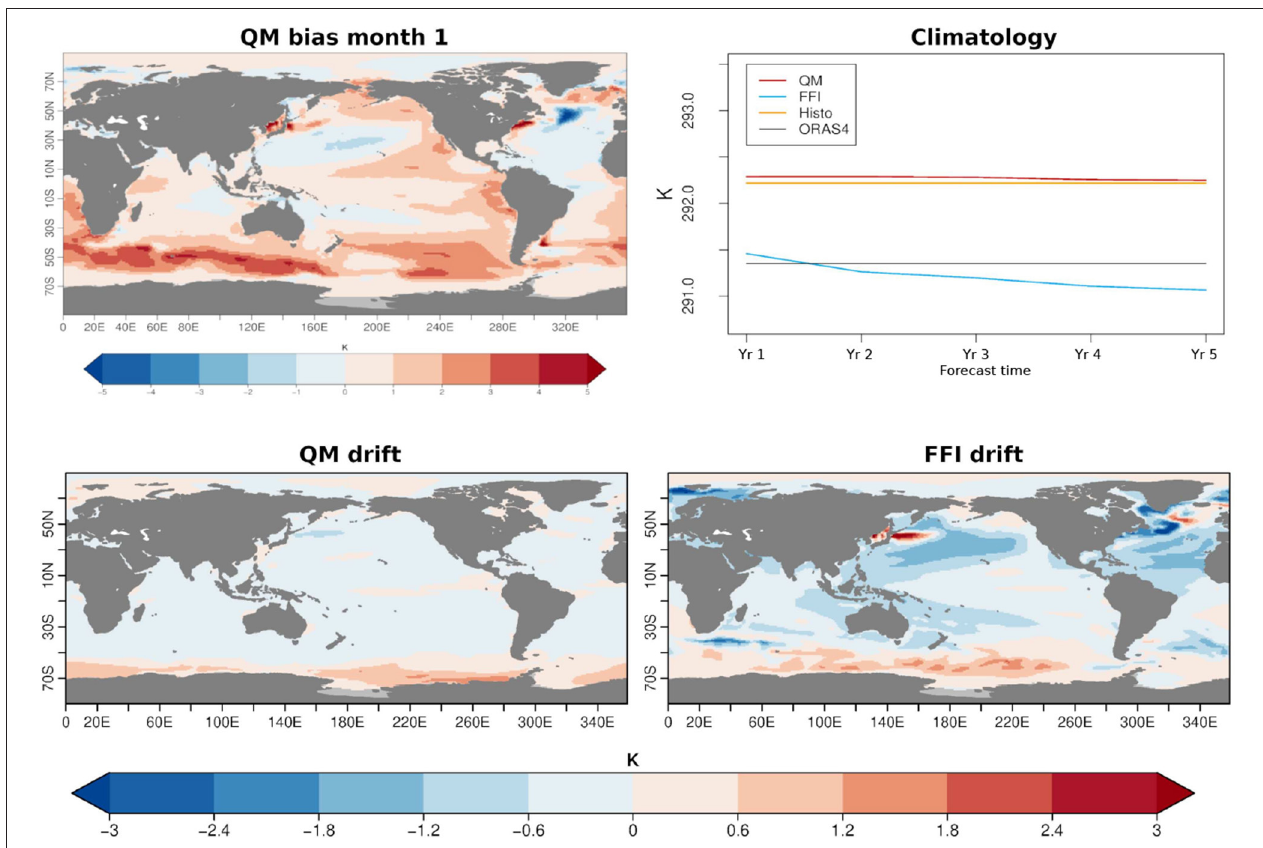
FIGURE 3 | Top left : SST bias of the QM experiment for the first forecast month calculated against NEMOVAR-ORAS4 reanalysis. Top right : forecast time-dependent climatologies of the annual mean global SST, calculated as explained in section 2.3. The ensemble mean climatology is shown in red for QM, in blue for FFI, in yellow for Histo, and in black for NEMOVAR-ORAS4. Bottom : drift calculated as the difference between the first and the last forecast year climatologies of QM (left panel) and FFI (right panel).